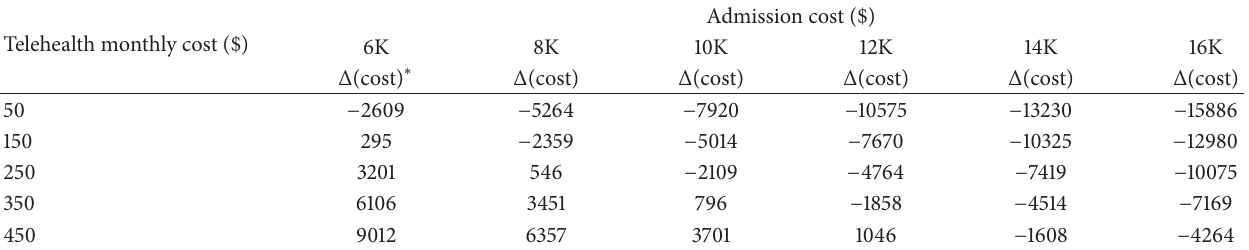
Table 6: Two-way sensitivity analysis: telehealth 3-year incremental cost and cost-effectiveness with varying monthly telehealth service costs and hospital admission costs.